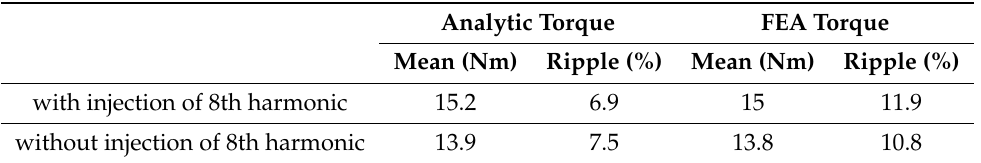
Table 3. Comparison of the analytically- and FEA-predicted torque-angle characteristics with and without injection of harmonic currents of rank